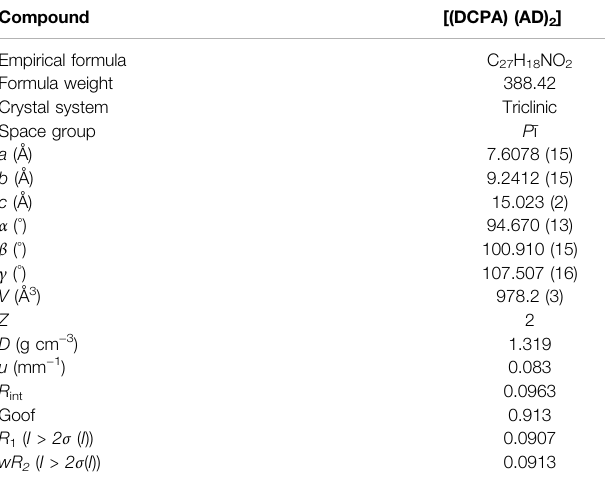
TABLE 1 | Crystallographic data for [(DCPA) (AD) 2 ].